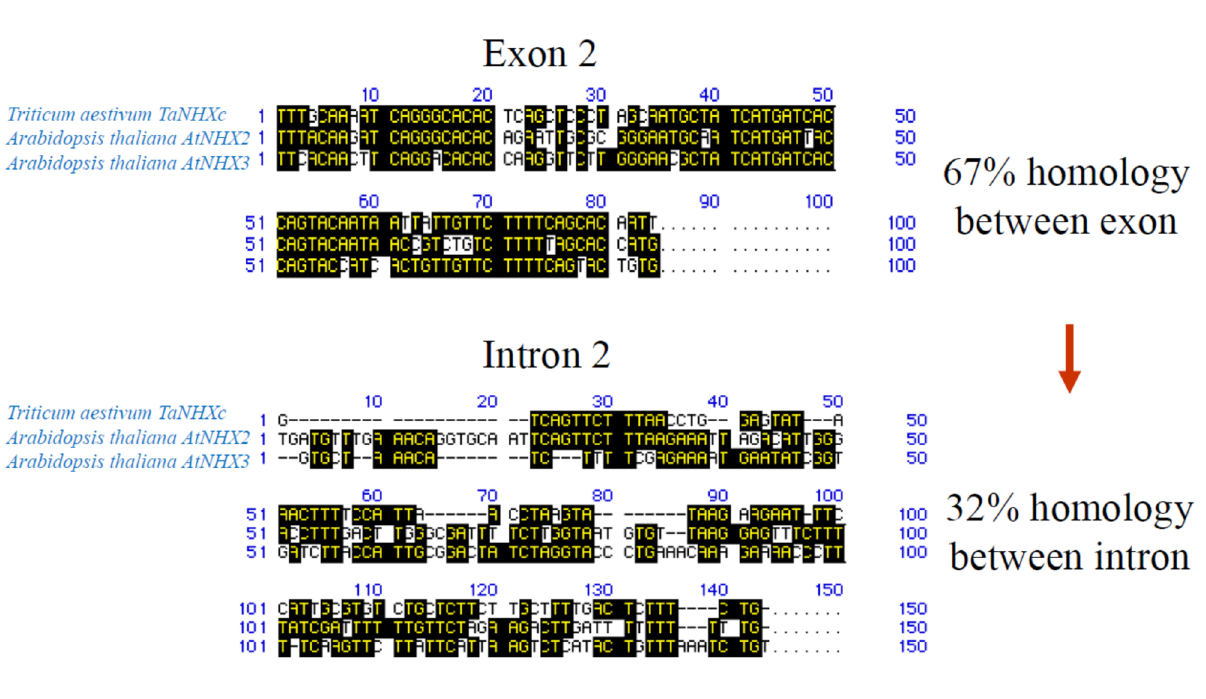
Figure 7 – Conserved exons and diverged introns of the Na + /H + anti porter gene between bread wheat and Arabidopsis thaliana . When homogeneity was analyzed regarding the 2nd exons and 2nd introns adjoining each other, homogeneity of the former was shown to be 67% among the 3 genes, while that of the latter was 32%. Introns showed a significant divergence between bread wheat and Arabidopsis thaliana compared with exons. Moreover, when the exon and intron structures of adjoining TaNHXa , b , and c were compared, the exons showed 64%~78% homogeneity among the 3 genes, while the homogeneity of introns was as low as 54%~56%, and there was a significant mutation in the intron. The level of homogeneity was high in the order of the transmembrane domain, regions between domains (of exons) and